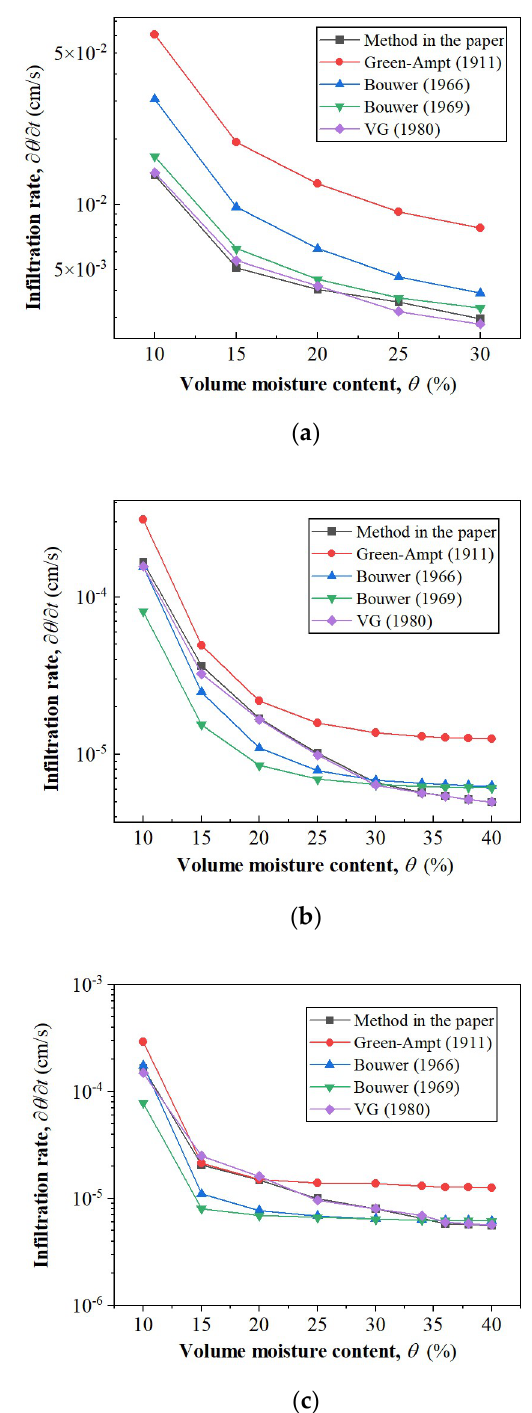
Figure 9. Comparison chart of numerical calculation results: ( a ) unconsolidated sand; ( b ) Touchet silty loam; ( c ) microsilica.